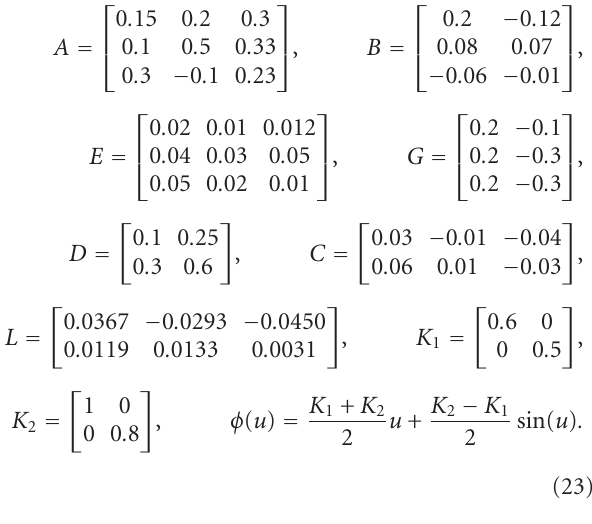
Figure 2: The trajectories of filtering state (cid:16) x ( k ).